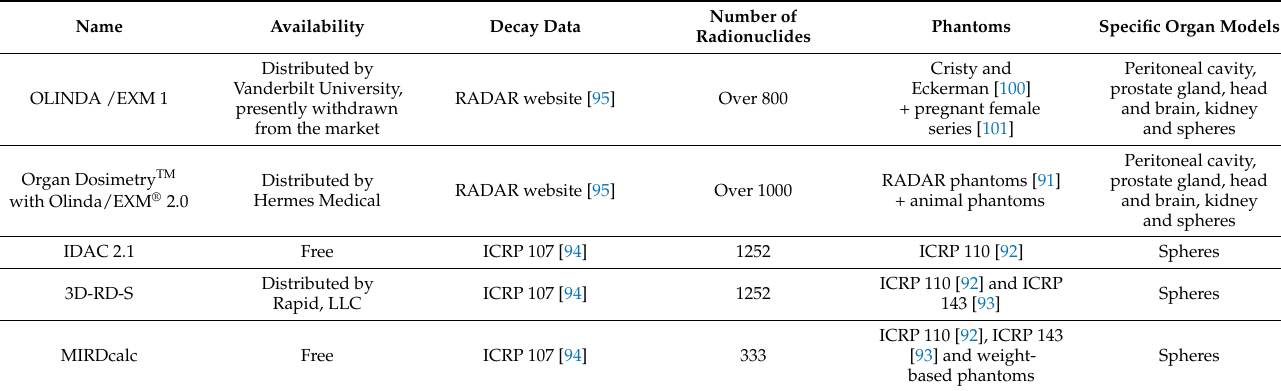
Table 4. Software packages for phantom-based